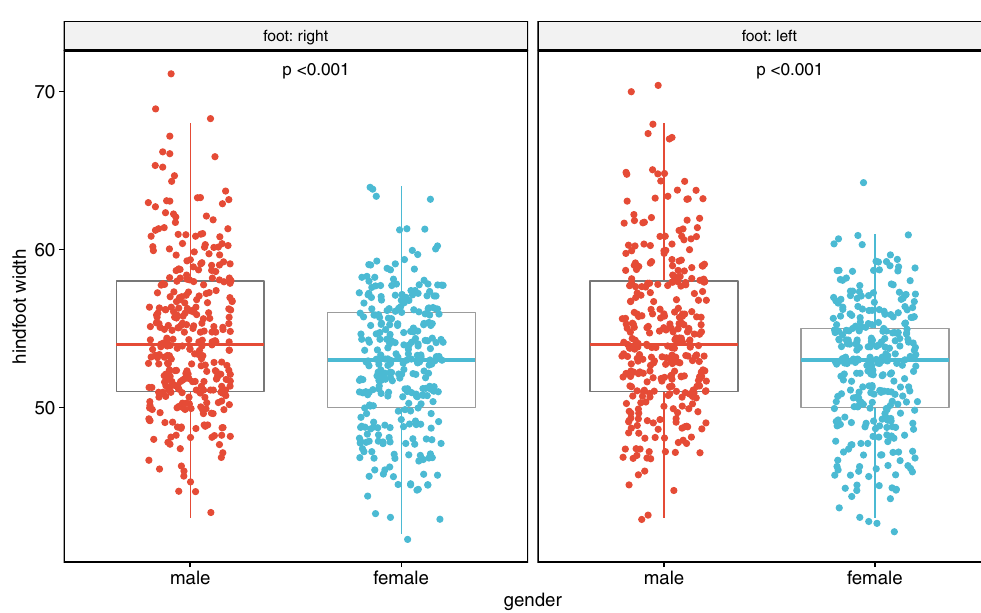
Figure 3. Dependence of hindfoot width on gender 15,16 .